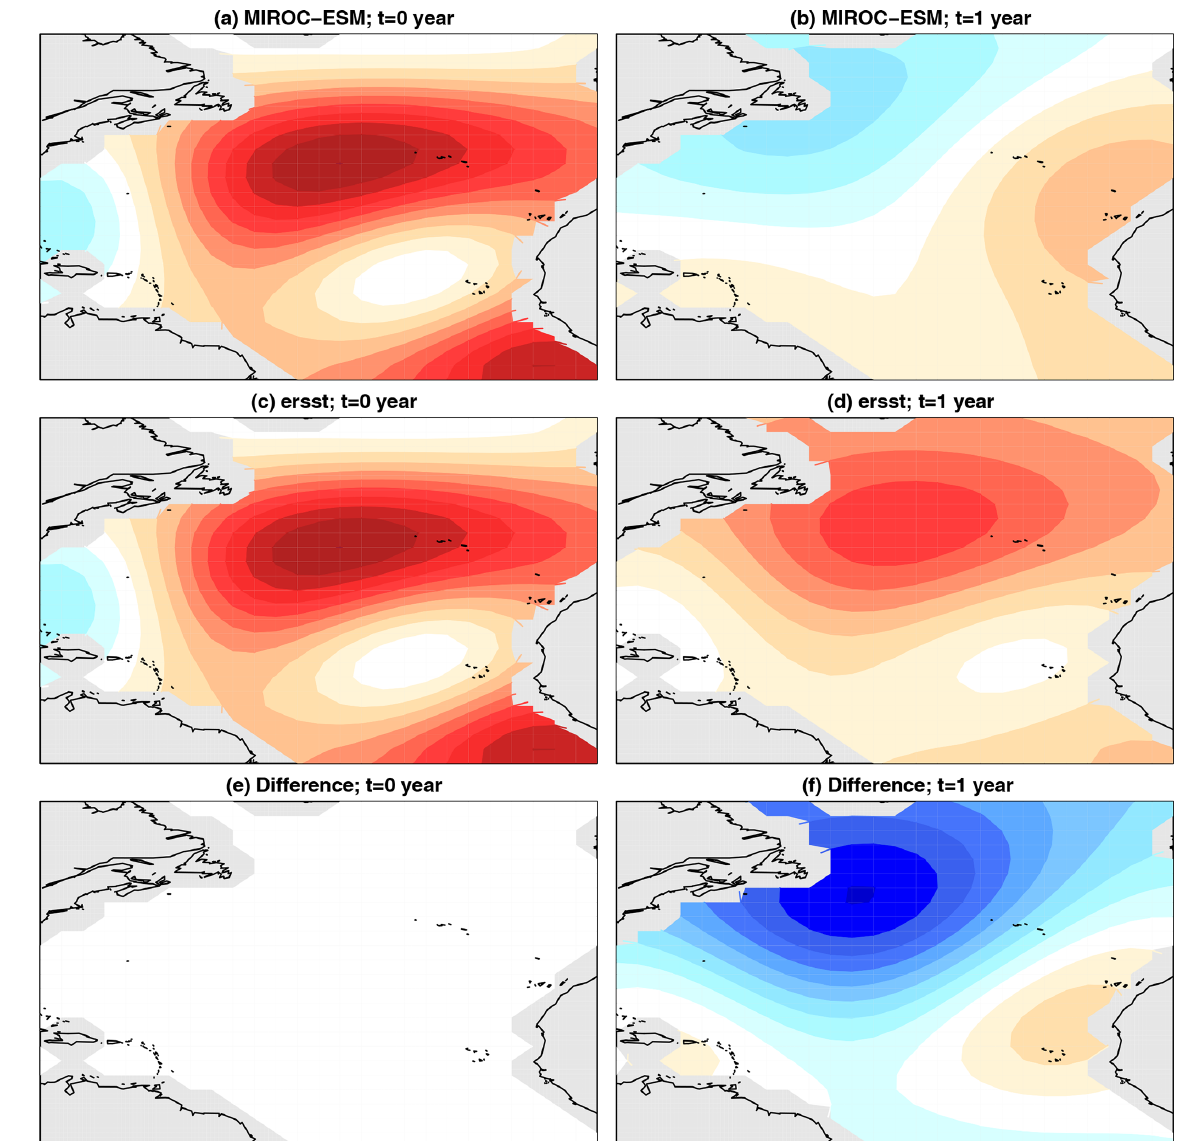
Figure 8. Same as Fig. 7 except for